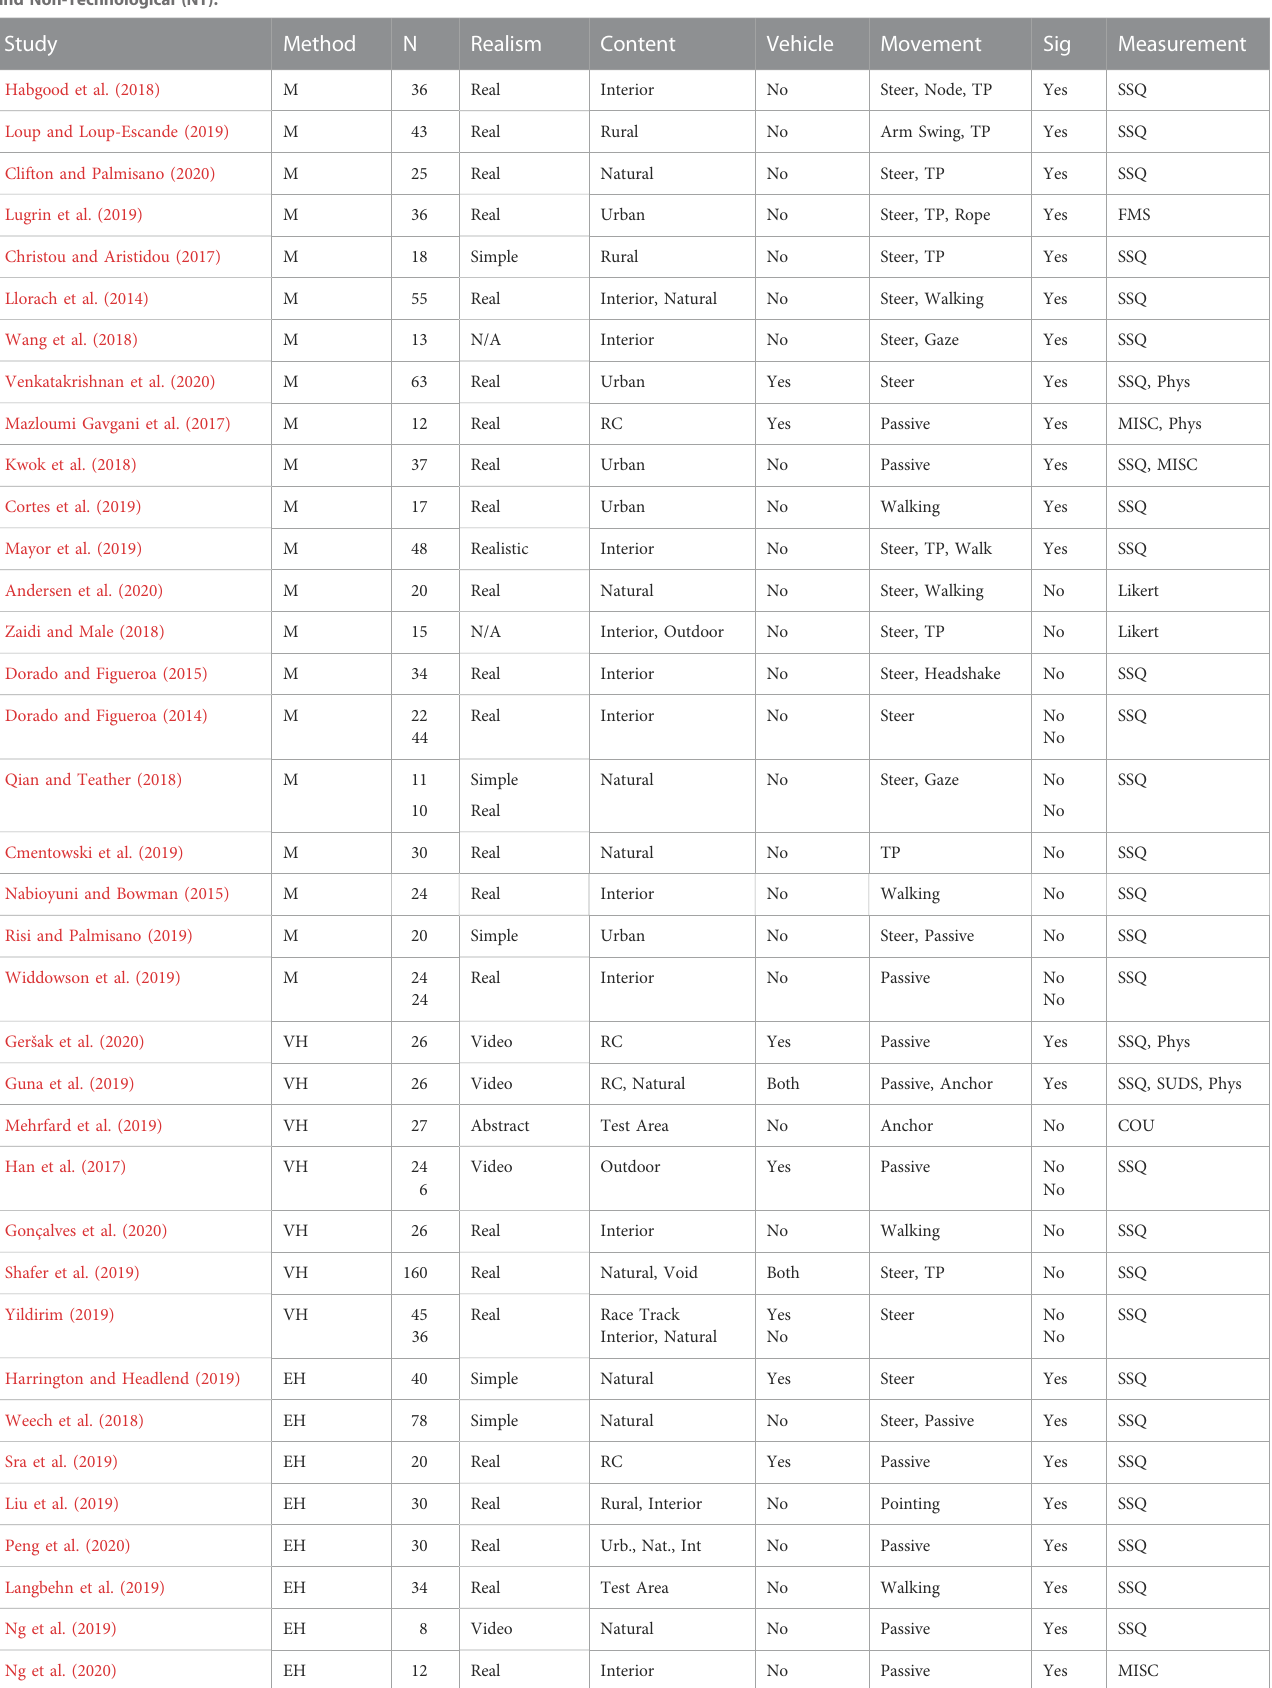
TABLE2Tableofcollected datafrom the fi nalfourcategories ofacceptedpapers.Thesecategories areMovement(M),ViewingHardware (VH),ExternalHardware(EH) and Non-Technological